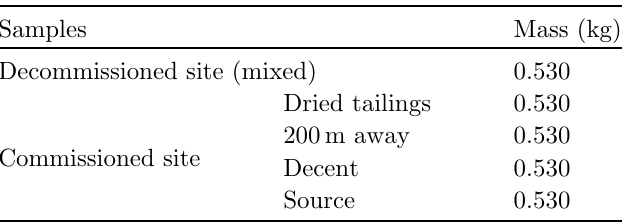
Table 1. Four samples collected from gold mine